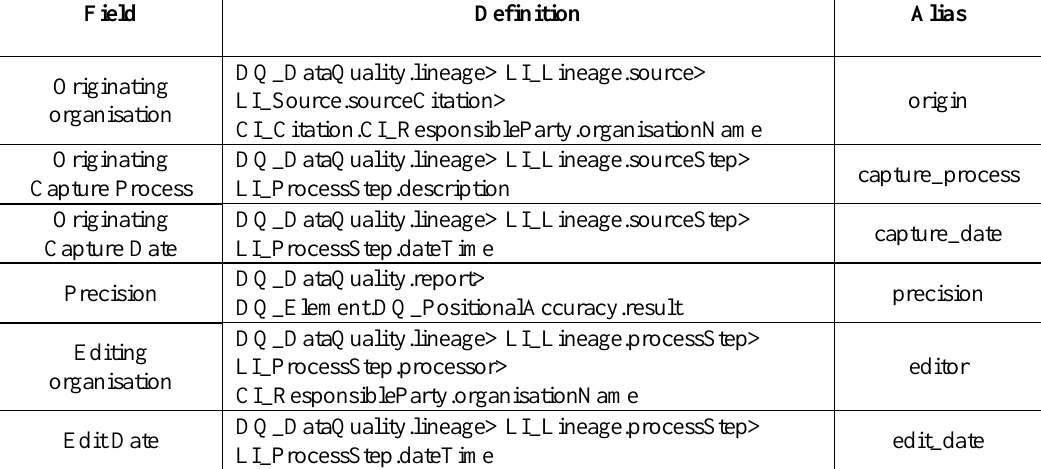
Table 3. ISO-based feature metadata schema, defined using ISO 19115 entities according to ISO 19109 guidelines (all being subclasses of MD_Metadata.dataQualityInfo). Both organisationName entries (origin, editor) may be replaced with (or supplemented by) individualName if required by the domain of